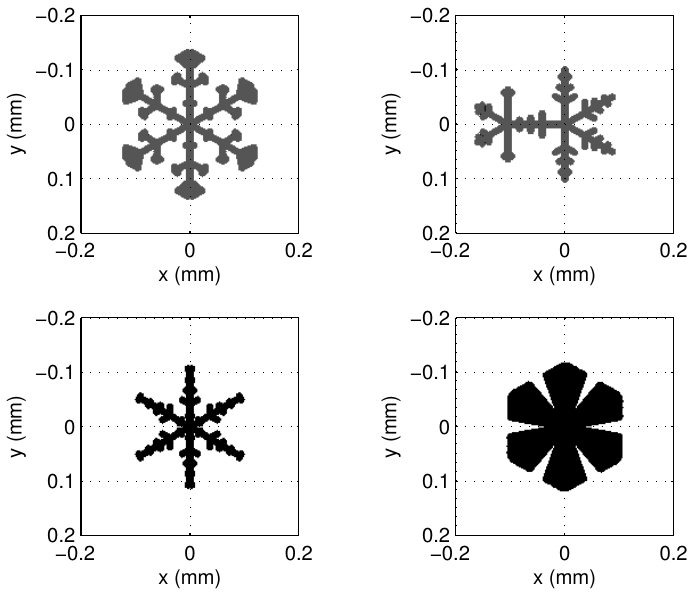
Some examples from our library of transparent phase objects describing ice crystals. A dendritic crystal with sector-like ends ( top left ); A malformed crystal ( top right ); An ordinary dendritic crystal ( bottom left ) and a crystal with sectorlike branches ( bottom right